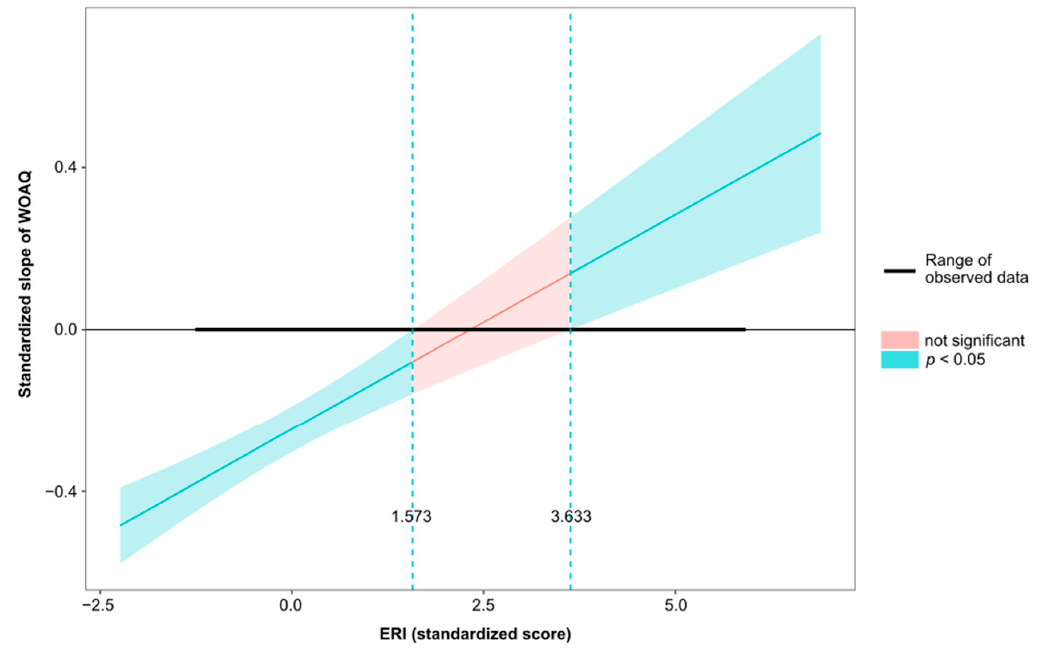
Figure 5. Johnson–Neyman Plot of the relationship between work organization quality and psycho- logical health, moderated by job strain.